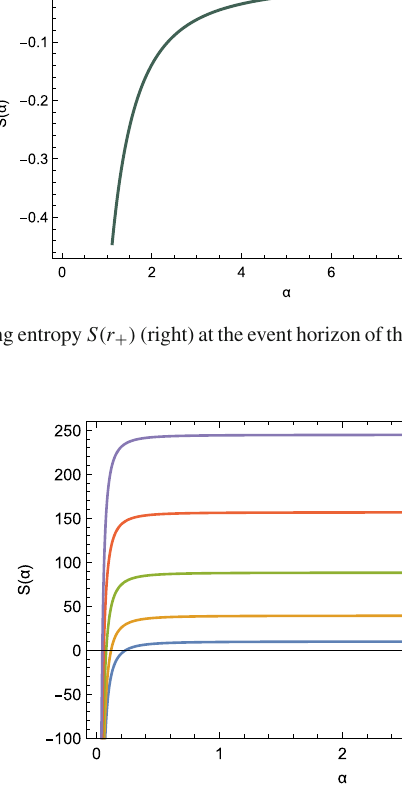
Fig. 6 The Bekenstein–Hawking S ( r + ) entropy of the charged solu- tion at the event horizon of the black hole as a function of α